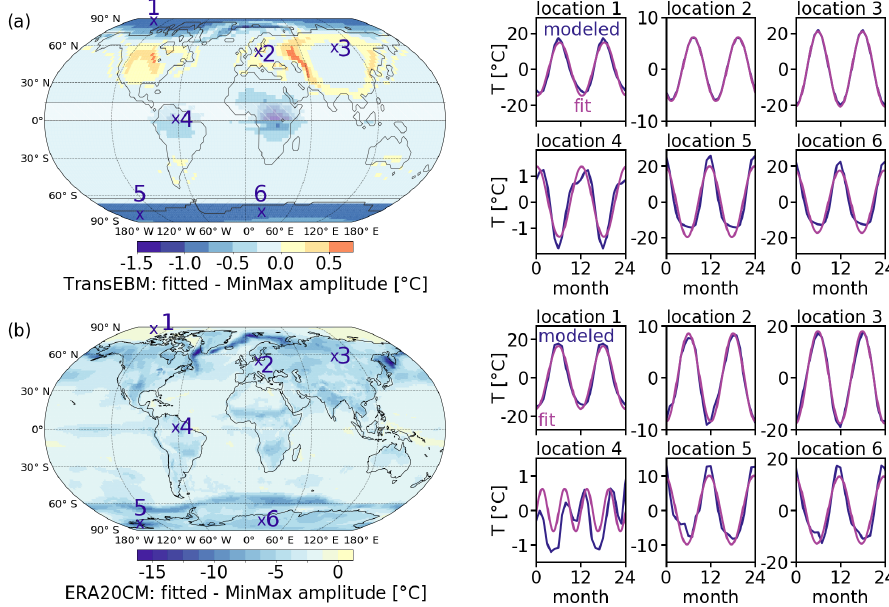
Figure C1. Amplitude of the seasonal cycle extracted from fitting a sine minus the amplitude that results from taking the difference between the maximal and minimal temperature. Model configuration as in Fig. 5. Time series from (a) TransEBM and (b) ERA-20CM (Hersbach et al., 2015) from 1900 to 1989CE, both were detrended. Six locations were picked as marked in the maps, for which 2 years of the time series and the fit are shown. For TransEBM, even the maximal differences are relatively small. In the polar regions the min–max amplitude is larger, over Asia and North America it is the other way around. For ERA-20CM the differences are larger, reaching up to around 15 ◦ in oceanic polar regions. The fit almost always produces smaller amplitudes. For both, locations 1–3 show places where the fit matches the time series very well. Location 4, on the other hand, lies close to the Equator inside the shaded area where the time series show only small variations throughout the year that are not sinusoidal. Locations 5 and 6 lie in Antarctica, where the fit is still applicable but is not able to fully capture the extrema.